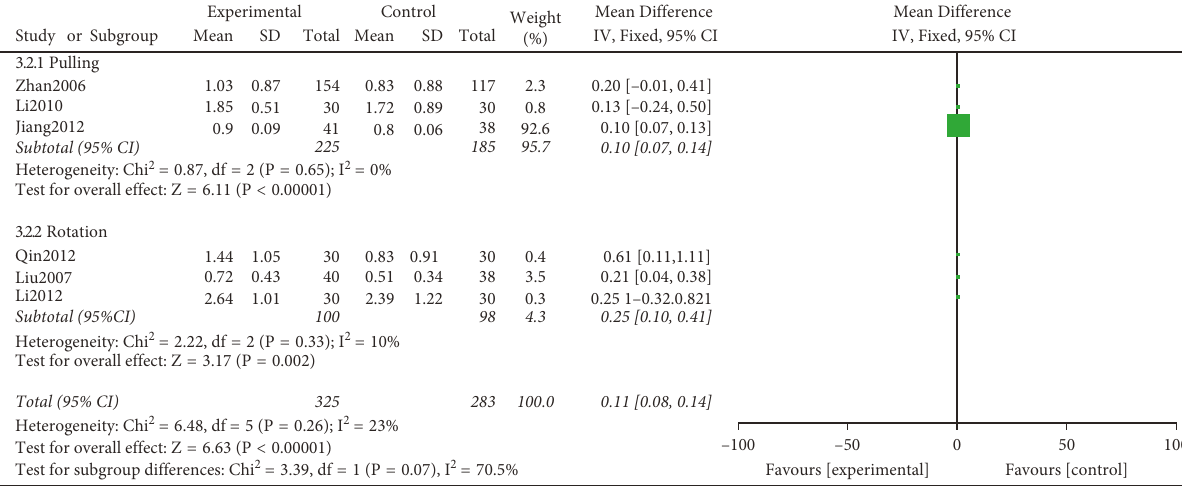
Figure 8: Comparison between the mean difference scores before and after treatment of symptom scores (upper limb anesthesia) of manipulation and cervical traction in the treatment of CSR.